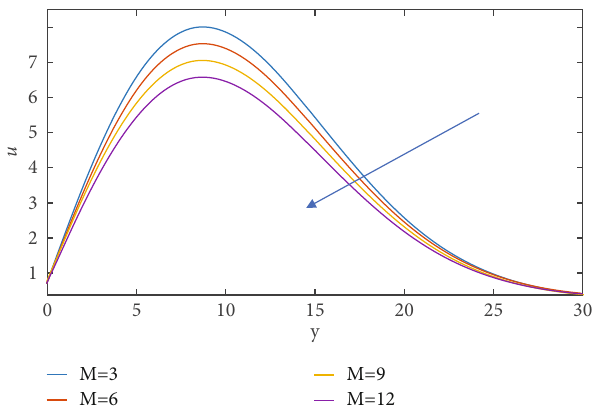
Figure 13: Increasing values of M for velocity fi eld when Gr = 5 , t = 2 , Kc = 1 : 5 , k = 1 , Gc = 5 , Ec = 0 : 1 , Pr = 6 : 2 , m = 1 , Sc = 2 : 01 , ⋋ = 1 , H = 2 , and F = 1